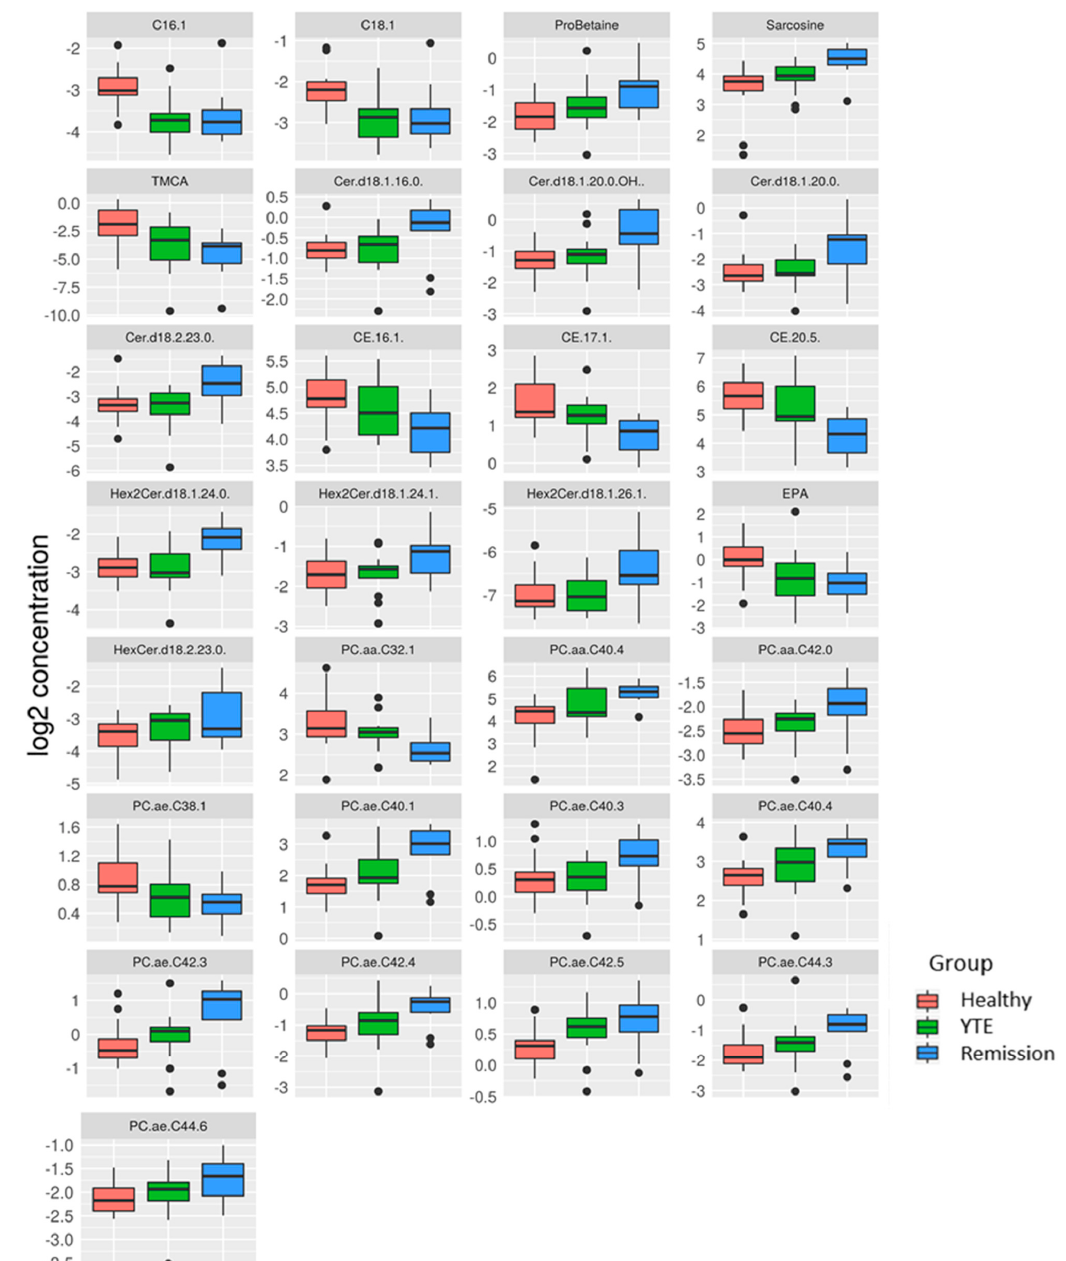
Figure 5. Box plots comparing metabolites after log-2 transformation in healthy controls, dogs with YTE, and dogs with YTE in clinical remission. Box plots of metabolites with significant differences between healthy dogs and YTE dogs in remission are shown. Box plots represent the 25–75th per- centile; the median is shown as the heavy dark horizontal line. Vertical lines extend to the minimum and maximum values. Dots represent outliers. Legend: C, carnitine; TMCA, tauro-muricholic acid; Cer.d, ceramide; CE, cholesteryl ester; Hex2Cer.d, dihexosylceramide; EPA, eicosapentaenoic acid; HexCer.d, hexosylceramide; PC, phosphatidylcholine.